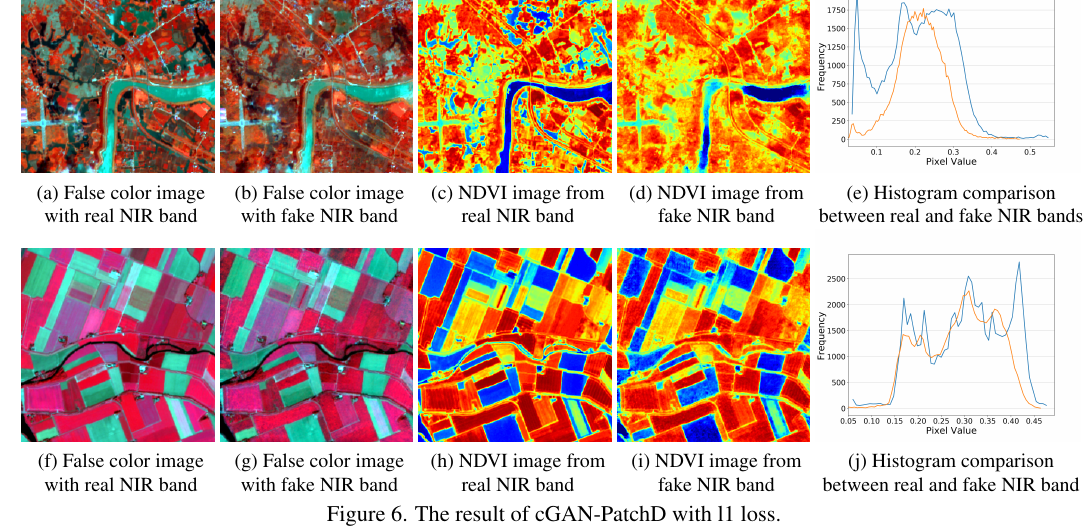
Figure 5. The results of U-net with l1 loss.